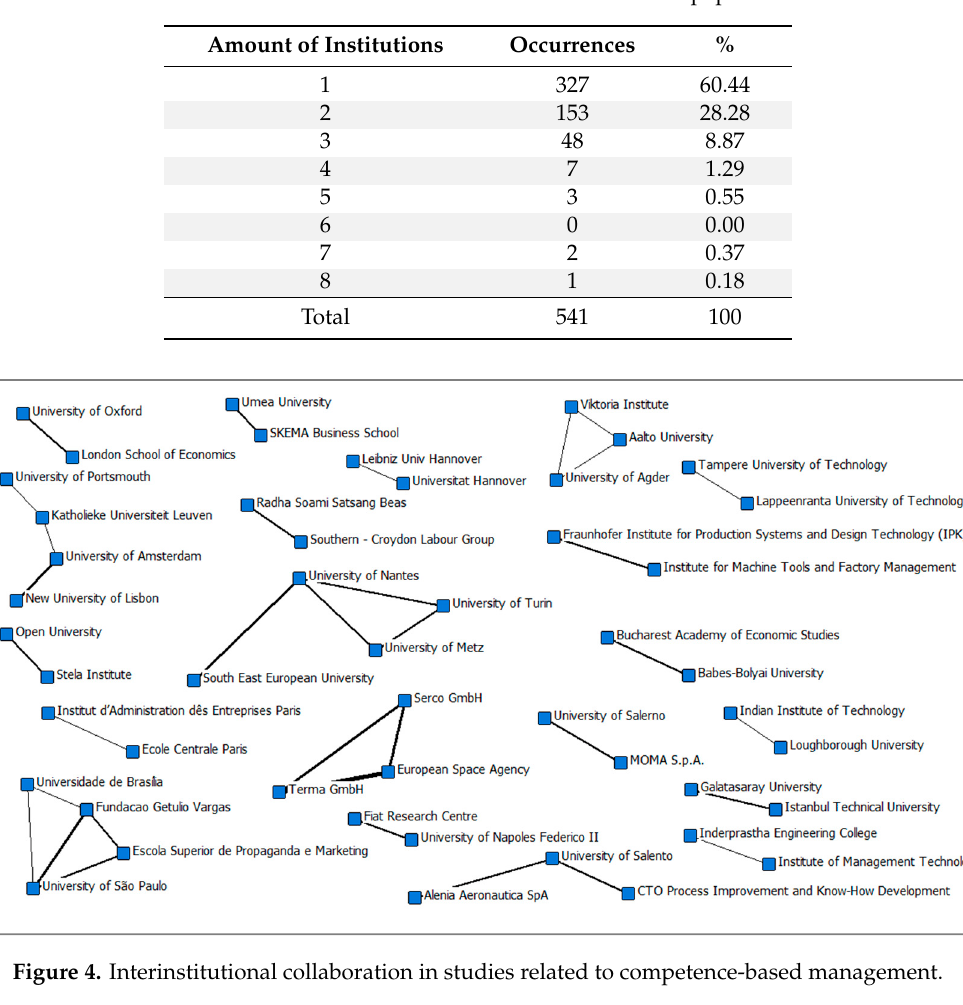
Figure 3. International collaboration in studies related to the field of competence-based management. Table 12. Amount of institutions associated in the papers.